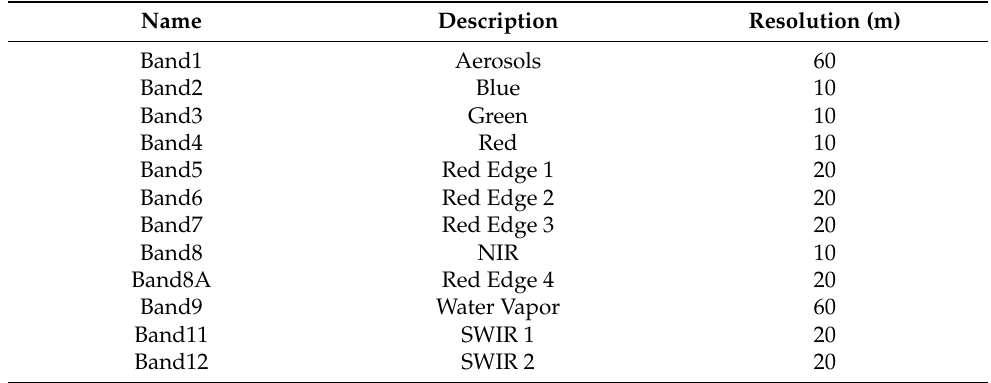
Table 2. Band introduction of Sentinel-2.